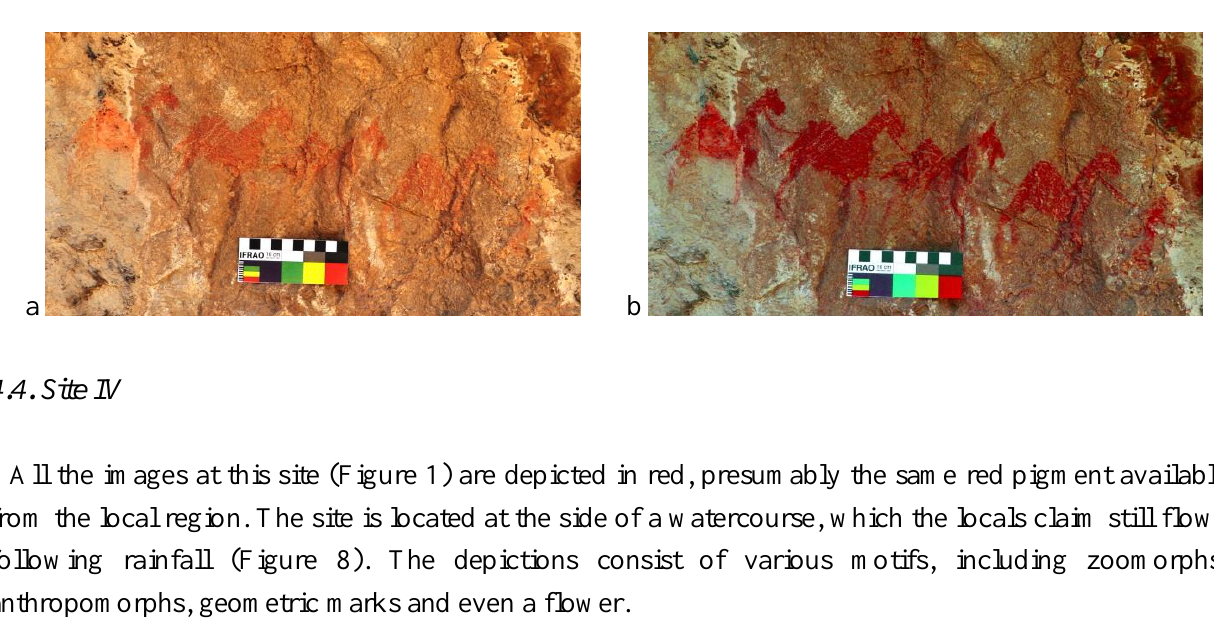
Figure 8. View of Site IV in